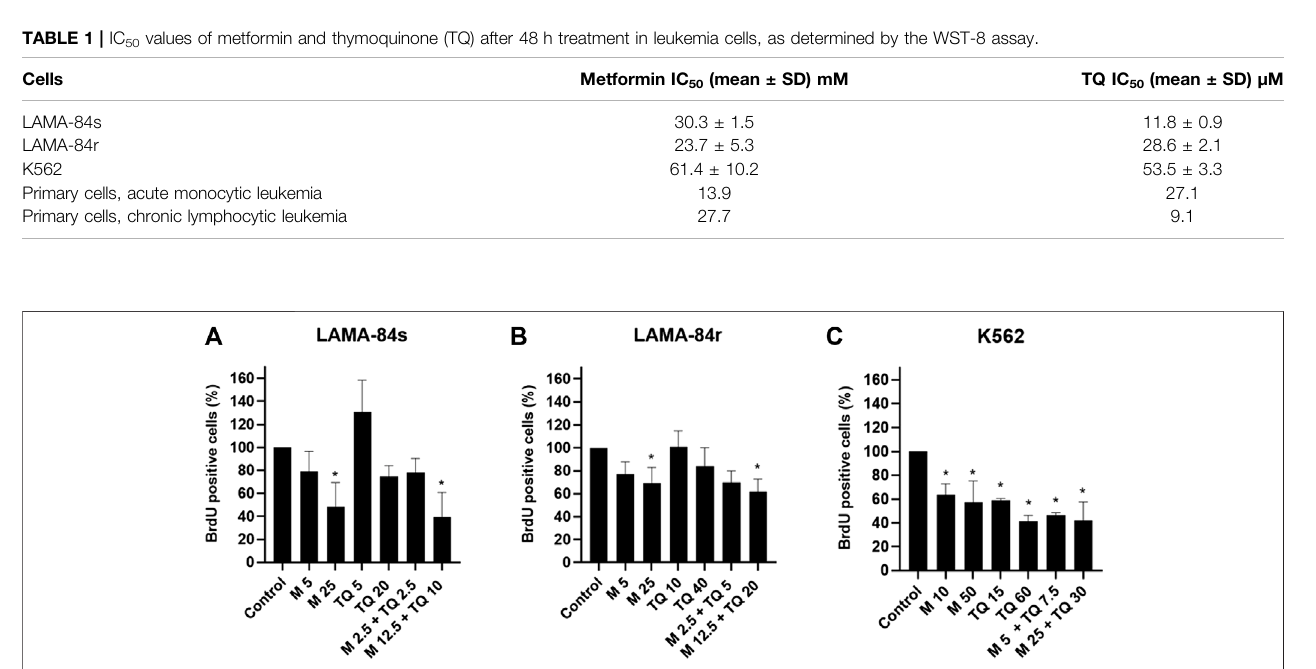
FIGURE 2 | Metformin (M), thymoquinone (TQ), and their combinatorial treatments applied for 48 h caused changes in proliferation as determined by the BrdU assay in (A) LAMA-84s, (B) LAMA-84r, and (C) K562 cell lines. Milimolar (mM) concentrations of metformin and micromolar (µM) concentrations of TQ were applied depending on the cell line as indicated at the X-axis of each graph. Data are presented as mean ± standard deviation. * p <